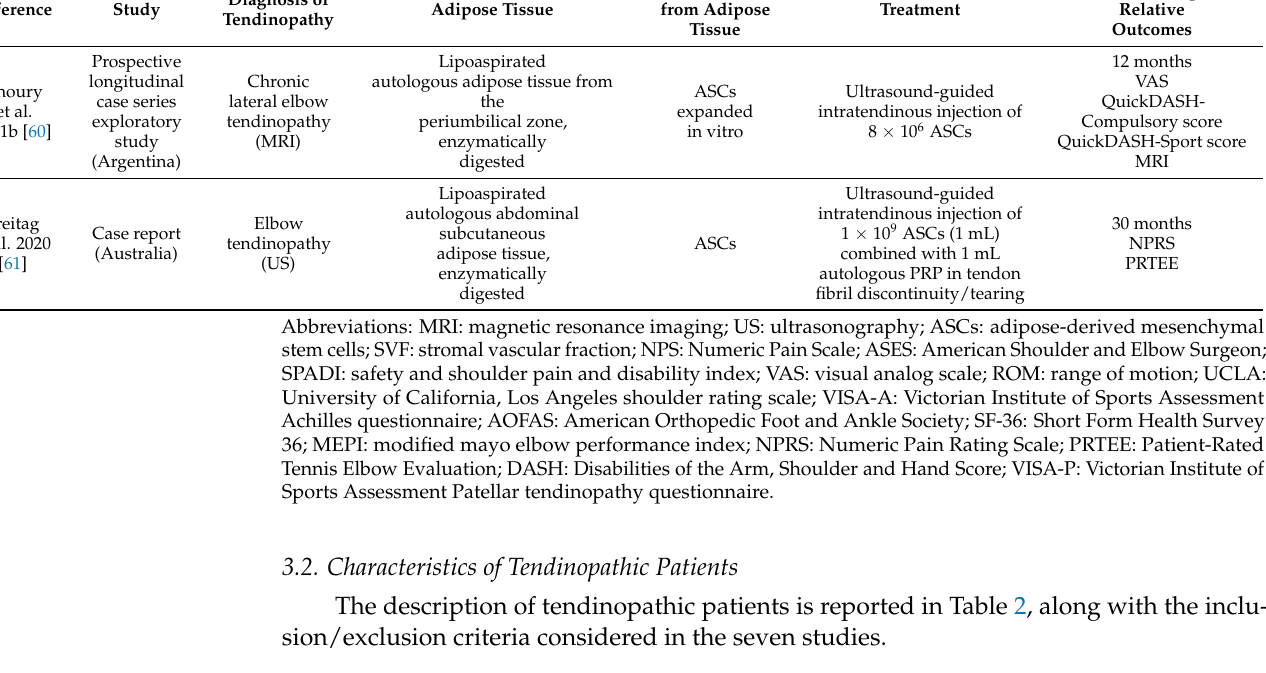
Table 2. Characteristics of patients with tendinopathy included in this systematic